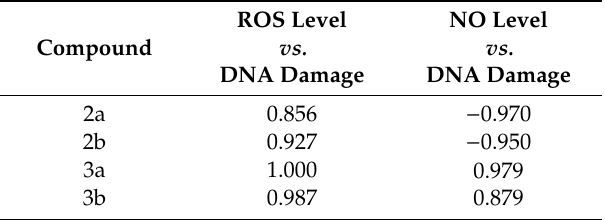
Table 2. Pearson correlation coefficients between DNA damage and reactive oxygen species (ROS) or NO levels. NO Level ROS Level Compound vs. vs. vs. Compound DNA Damage